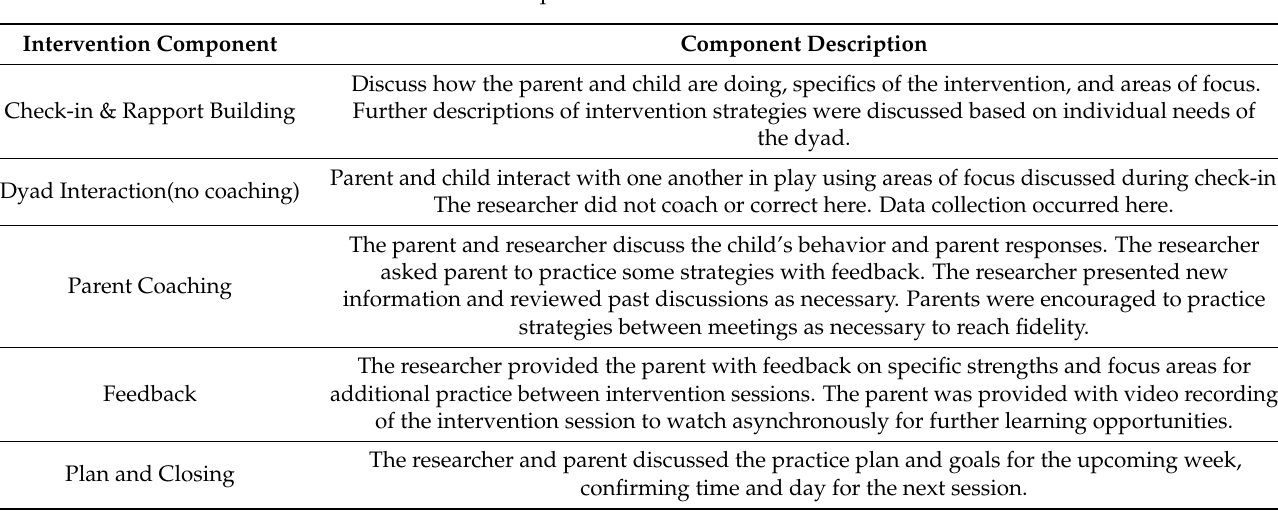
Table 3. Sequence of Intervention